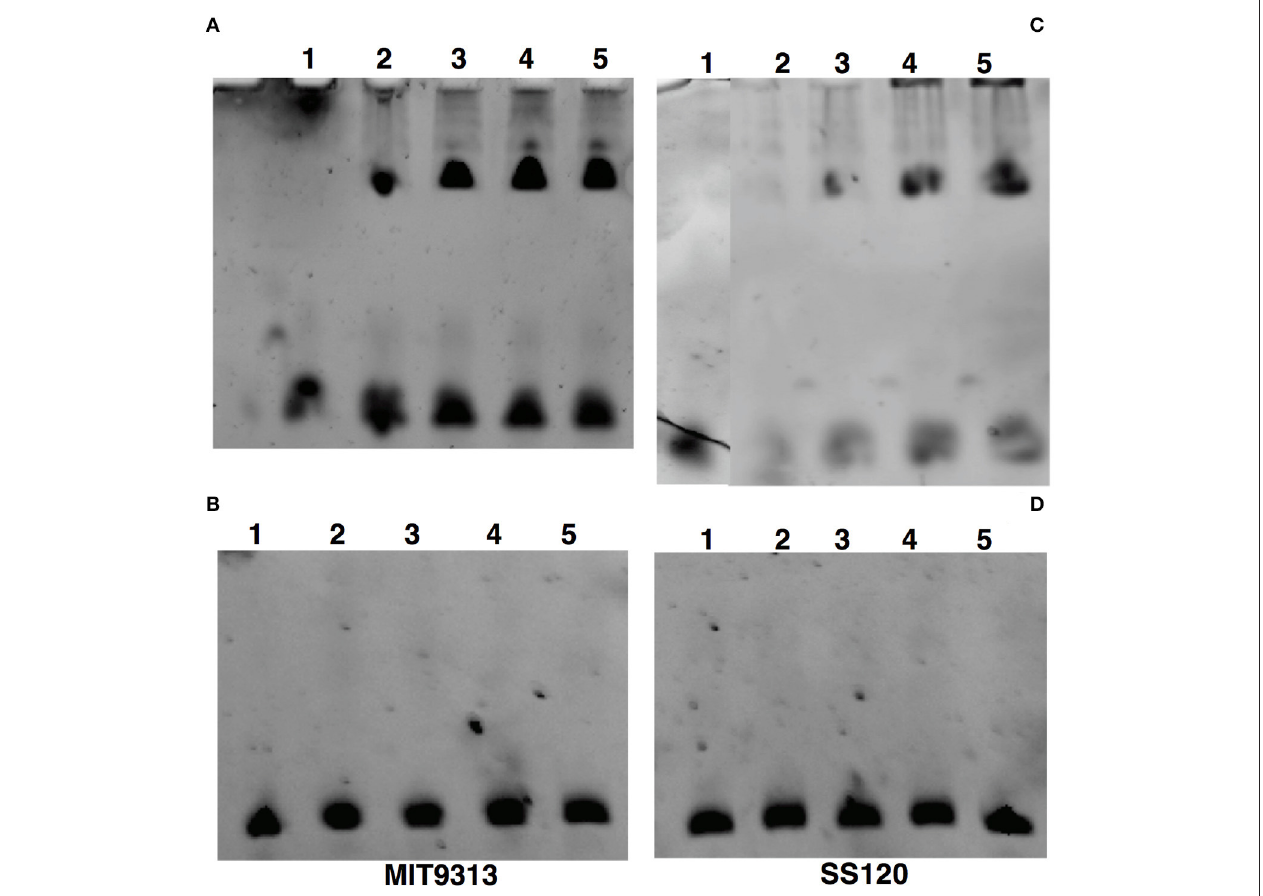
FIGURE 6 | EMSA analysis of the specific binding of NtcA to the glnA promoter of Prochlorococcus sp. MIT9313 (A,B) and SS120 (C,D) . (A,C) The binding of 1 µ M NtcA to the wild-type glnA promoter DNA was examined by EMSA analysis in the presence of the indicated concentrations of 2OG. (B,D) The binding of 1 µ M NtcA in the presence of the indicated concentrations of 2OG to mutated glnA promoter. The samples had the following composition: Lane 1, glnA -promoter; lane 2, glnA -promoter + NtcA (1 µ M); lane 3, glnA -promoter + NtcA (1 µ M) + 2OG (1mM); lane 4, glnA -promoter + NtcA (1 µ M) + 2OG (5mM); lane 5, glnA -promoter + NtcA (1 µ M) + 2OG